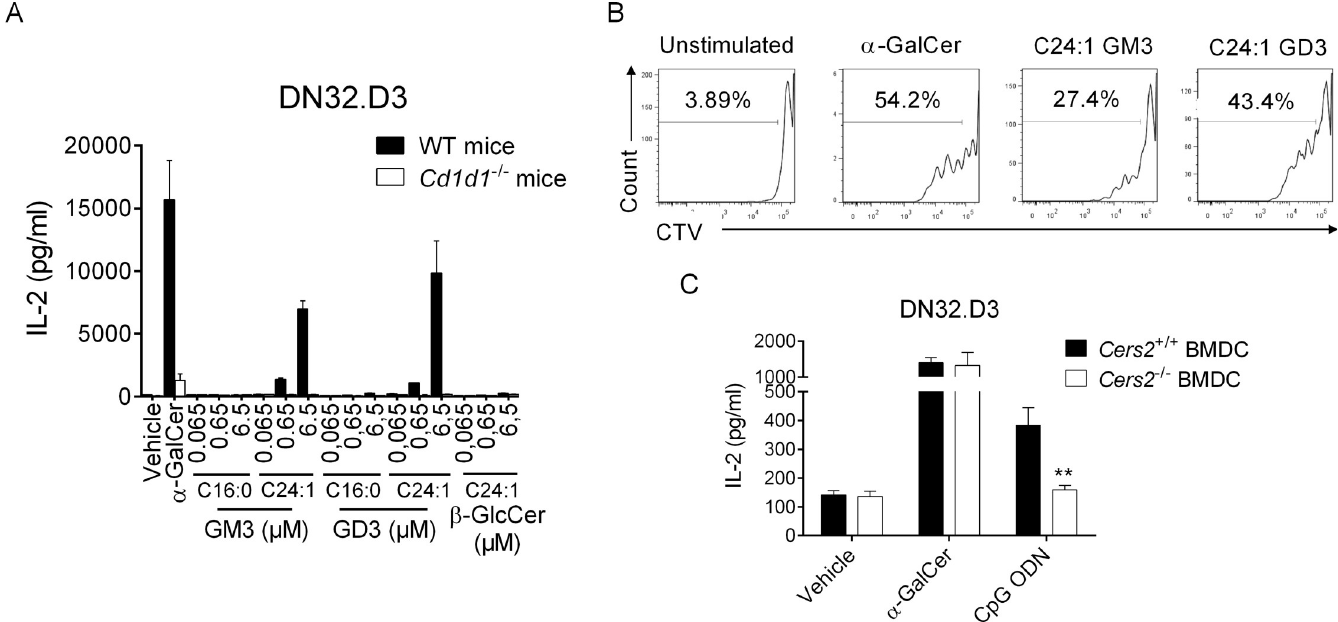
Fig 5. In vitro activity of gangliosides on i NKT cells. (A) DCs derived from WT or CD1d1 − / − mice were cultured with the mouse i NKT hybridoma DN32.D3 in presence of purified glycolipids at the indicated concentrations or vehicle in complete RPMI media for 24 h. IL-2 production was quantified by ELISA. Means ± SEM of one representative experiment out of three performed in triplicates are shown. (B) Cell Trace Violet-labeled spleen cells from C57BL/6 mice were cultured in absence or presence of α -GalCer (100 ng/ml), C24:1 GM3 (6.5 μ M), or GD3 (6.5 μ M) in complete RPMI plus recombinant IL-2. After 72 h, cells were harvested and analyzed by flow cytometry for CTV detection in live i NKT cells. Dot plots are representative of one experiment out of three. (C) DCs derived from Cers2 +/+ or Cers2 − / − mice were cultured with DN32.D3 in presence of α -GalCer (20 ng/ml), CpG ODN (2 μ g/ml), or vehicle in complete RPMI media for 24 h. Means ± SEM of IL-2 concentrations of one representative out of three experiments performed in duplicates are shown. �� P < 0.01. Underlying data used in the generation of this figure can be found in S1 Data. α -GalCer, α -galactosylceramide; Cers, ceramide synthase; CpG, cytosine-phosphate-guanine; CTV, cell trace violet; DC, dendritic cell; IL-2, interleukin 2; i NKT, invariant natural killer T; ODN, oligodinucleotide; RPMI, Roswell Park Memorial Institute medium; WT, wild-type.